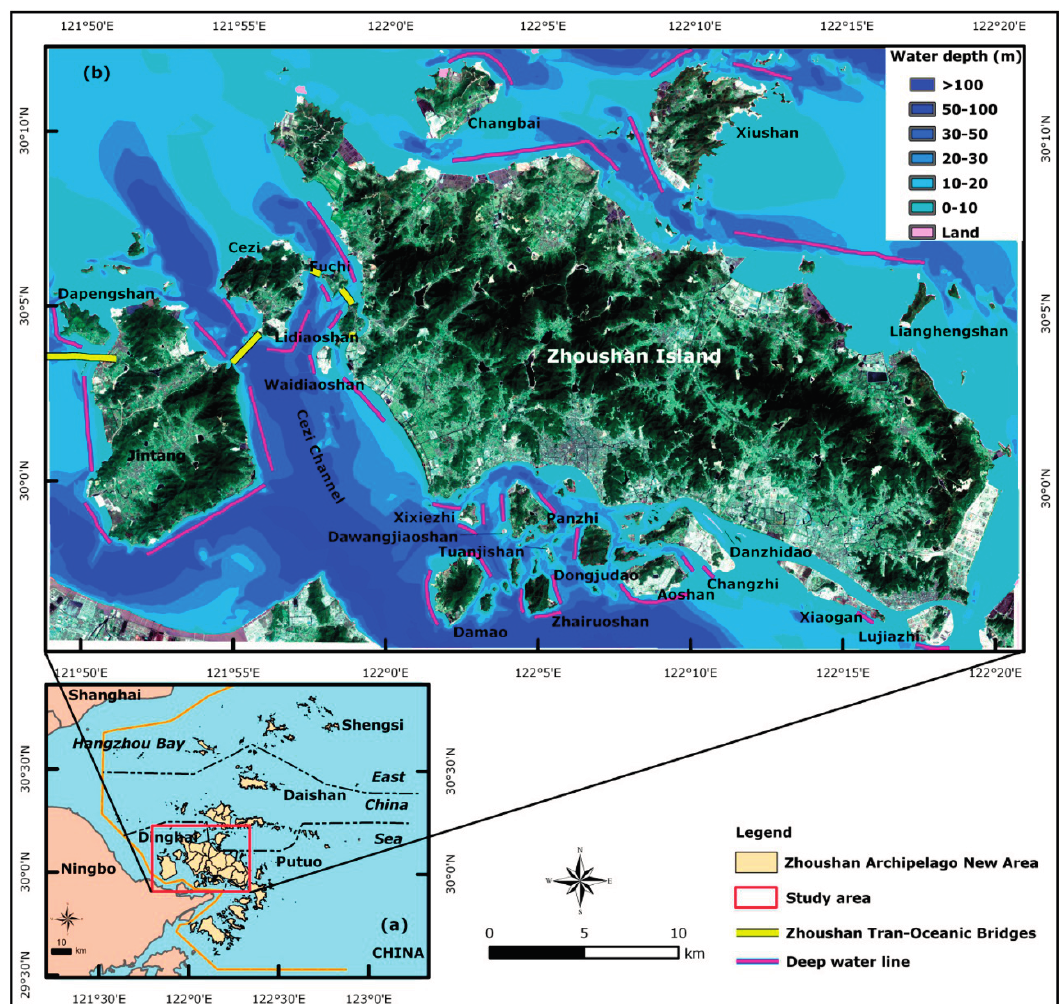
Figure 1. ( a ) The location of the Zhoushan Islands in China; ( b ) The landmass of the study area shown by the fused SPOT5 image in 2011, as well as the water depth (m)